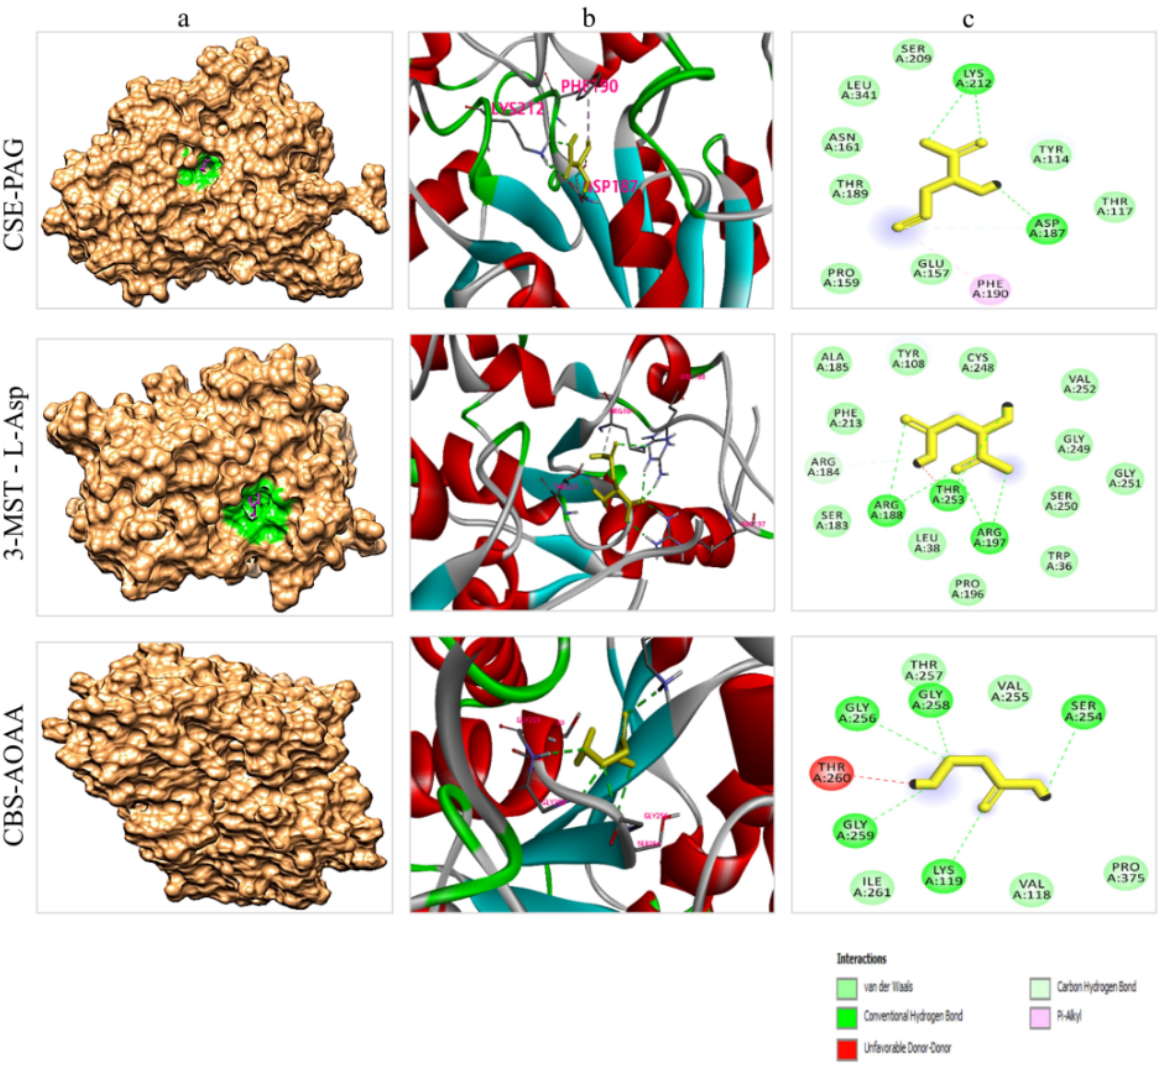
Figure 7. Visualization of drug–protein interaction after molecular docking ( a ) Depiction of each protein docking interaction pocket (magenta: drug molecule, green: drug pocket area in the corre- sponding enzymes). Note: In the CBS-AOAA complex, the pocket cannot be seen because the drug interaction area is in the cleft of the protein. ( b ) The 3D interaction sites of drugs with corresponding enzymes. ( c ) The 2D interaction of the interacting amino acid residues of the proteins with each drug